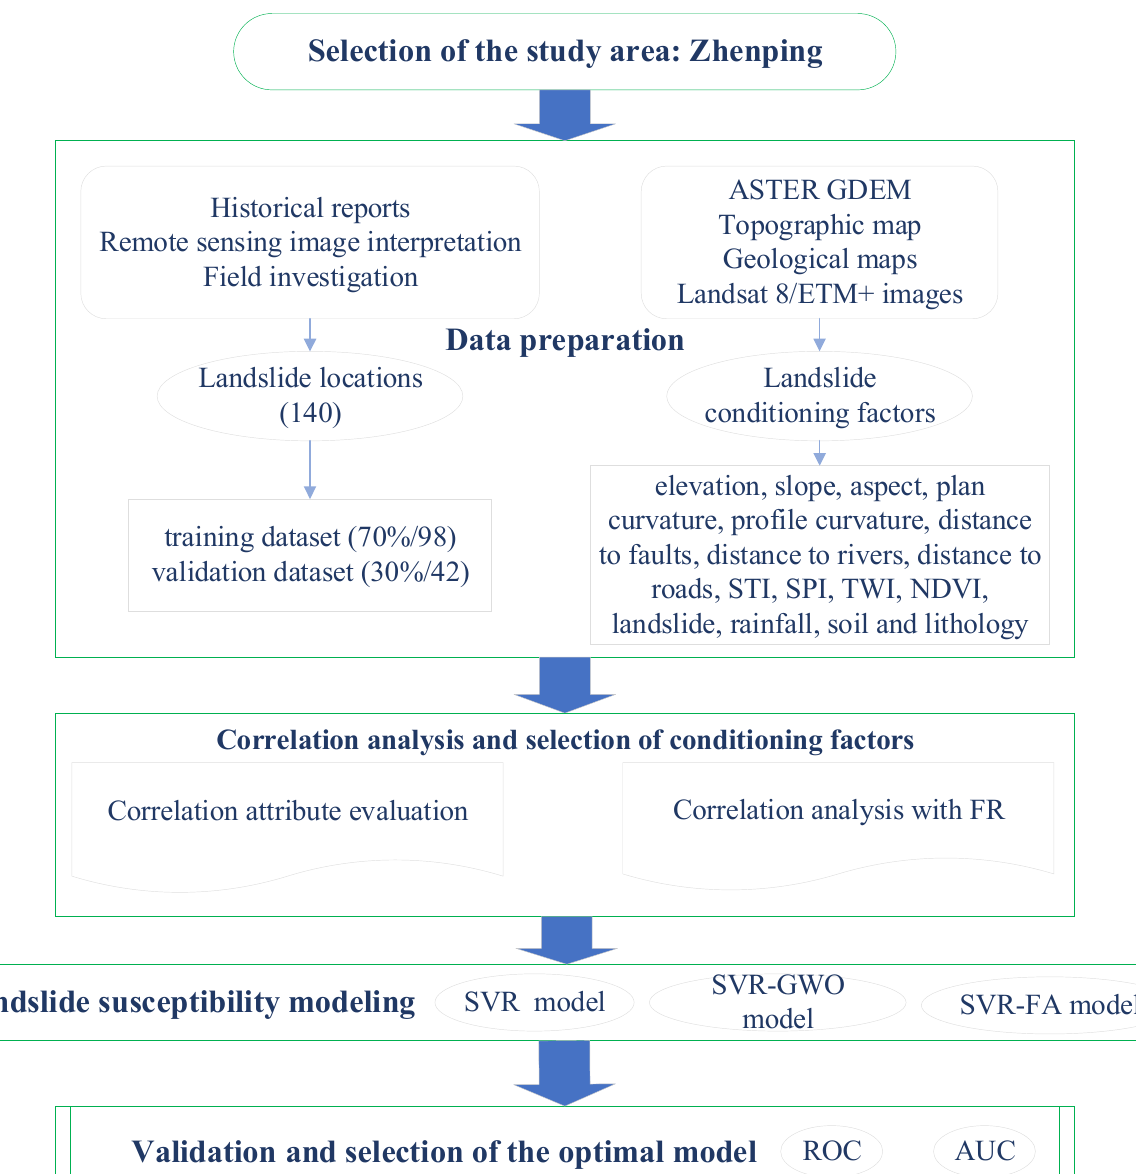
Figure 3. Flowchart used in this study.